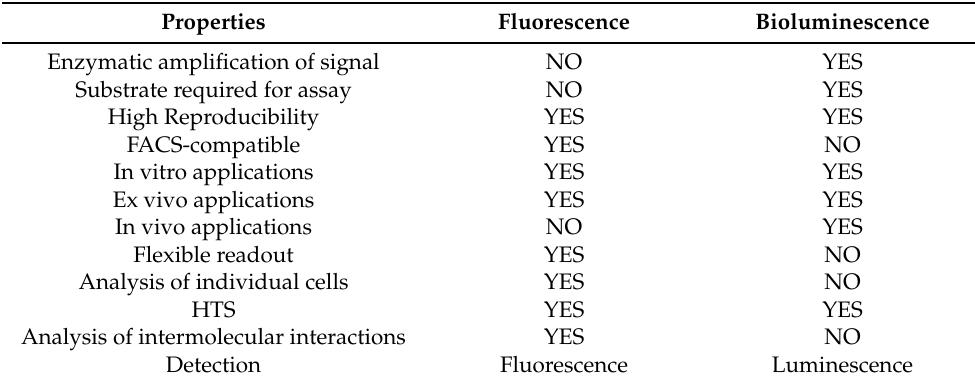
Table 1. Fluorescence versus bioluminescence, features and